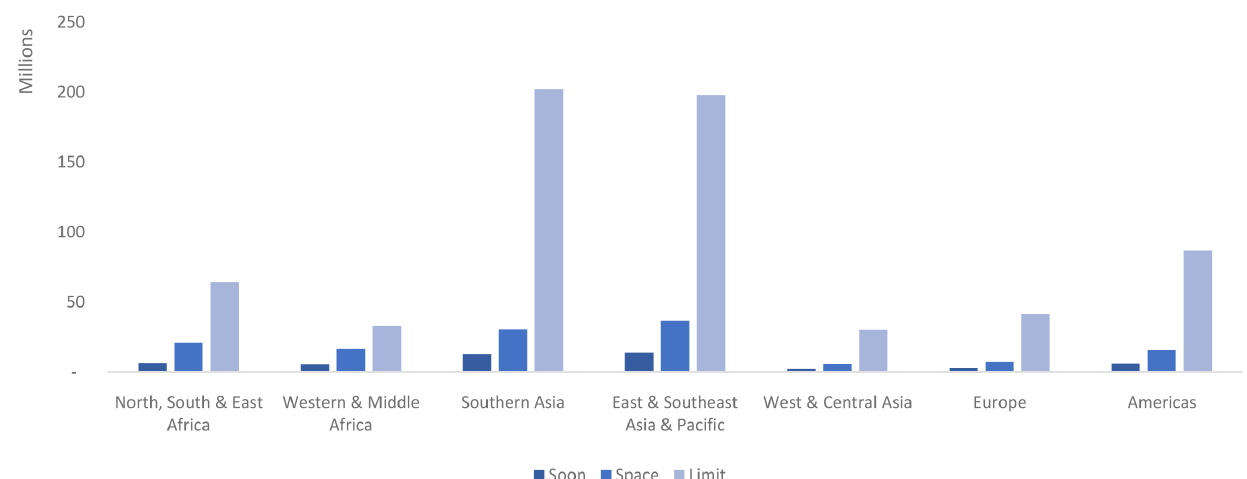
Figure 8. Married users by market segment and region in 2040, in millions. This graph shows the total number of married users (in millions) distributed by market segment and region. Married women wanting no more children (limit) in Southern Asia account for the single largest